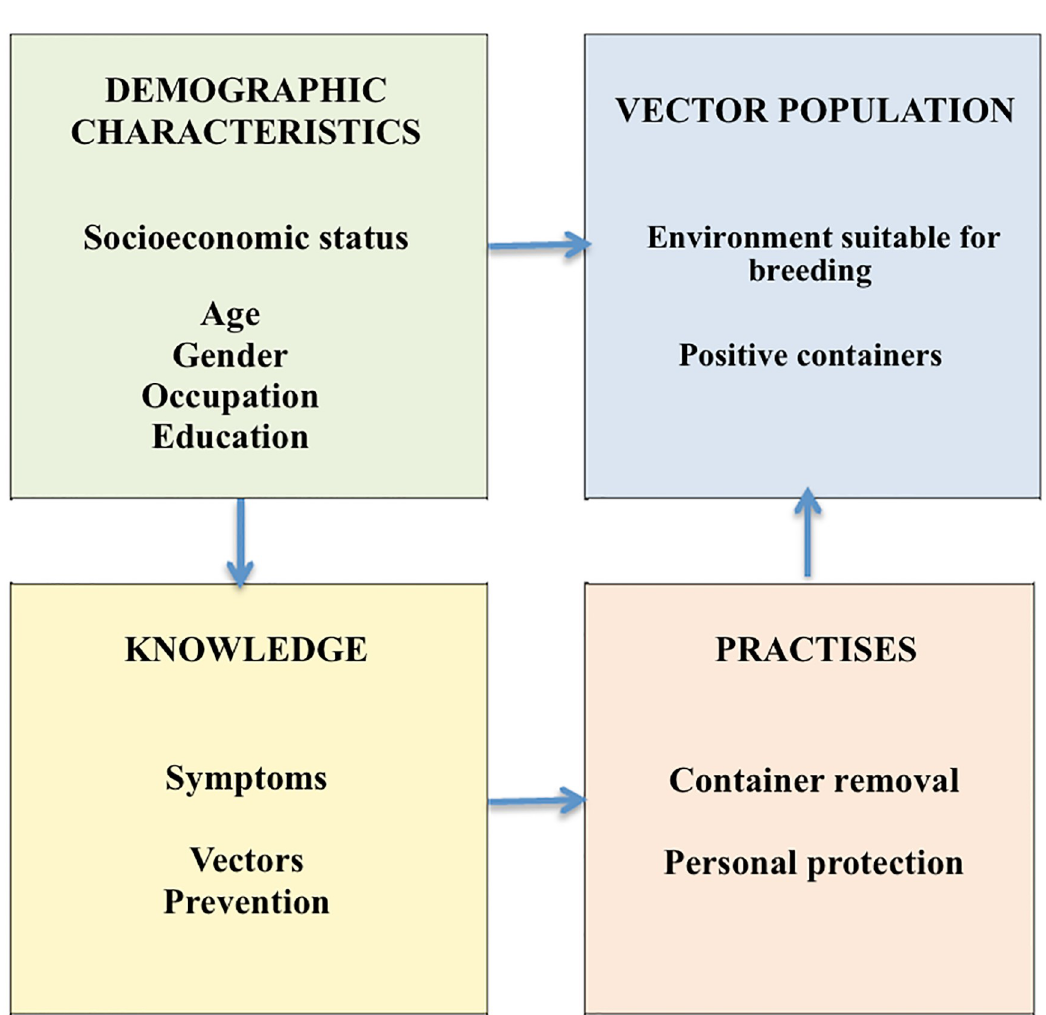
Fig 1. Factors involved in the control or spread of dengue through human and Aedes aegypti